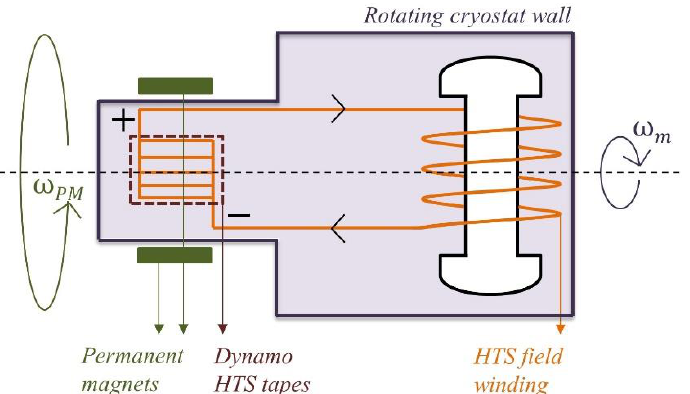
Figure 5. Contactless supply system of the rotor HTS field winding of the EcoSwing turbine based on the dynamo flux pump.